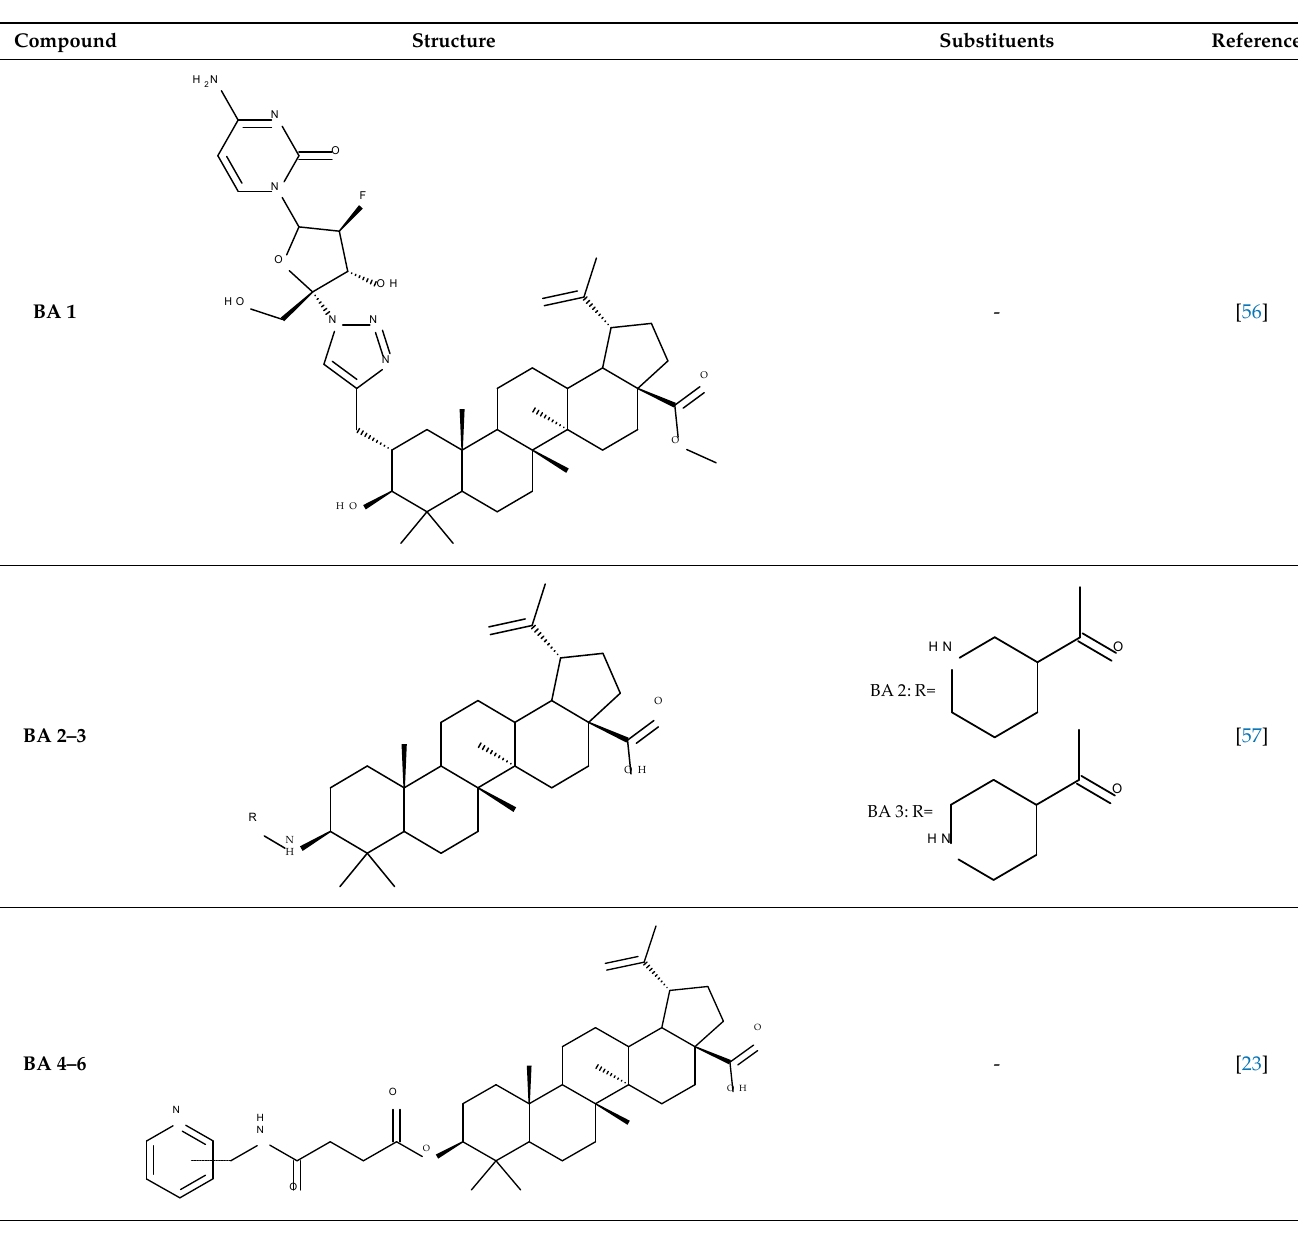
Table 4. Chemical structures of BA derivatives.